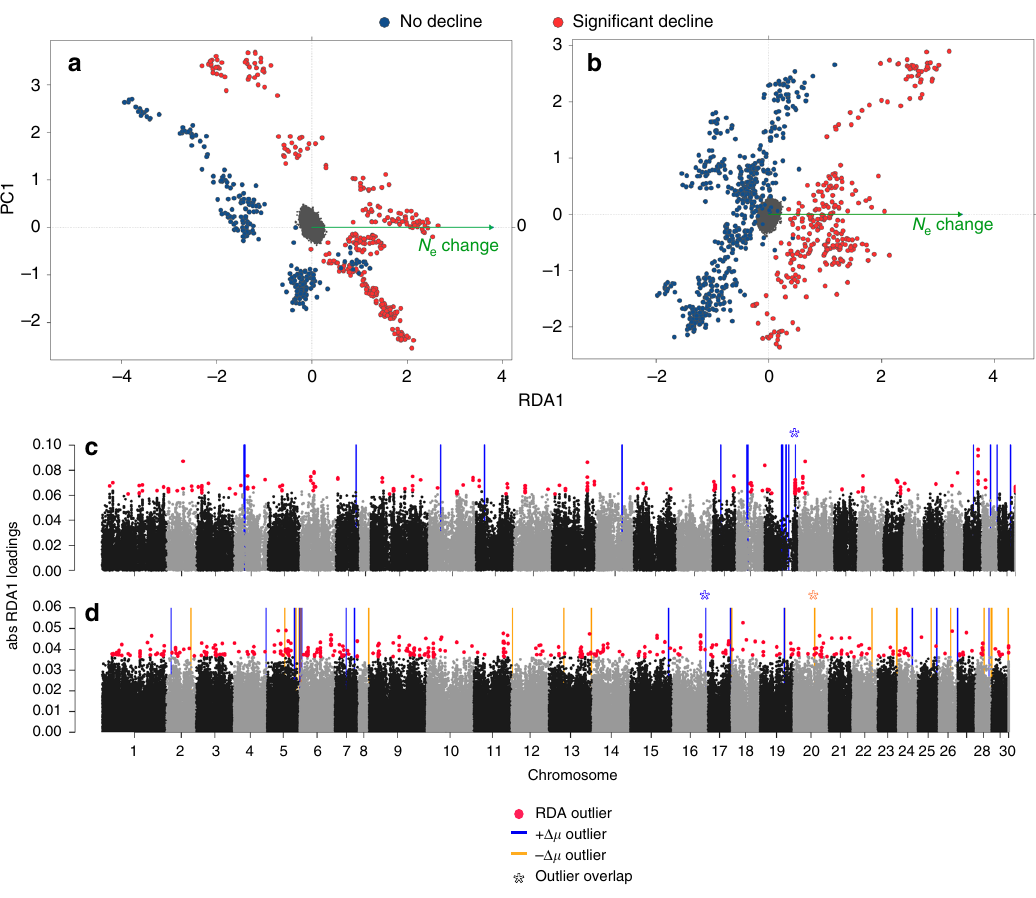
Fig. 3 Genomic basis of population declines across Atlantic salmon using high-density genomic dataset. Redundancy analysis (RDA) separated signi fi cantly declining (red) and non-declining (blue) populations along the fi rst axis in ( a ) North America and ( b ) Europe. Absolute RDA1 scores are presented in Manhattan plots for both continents ( c , North America; d , Europe) with decline-associated loci (outliers) highlighted in red. Coloured lines represent regions showing signi fi cant changes in selective sweeps ( Δ µ ) between declining and non-declining populations, where blue lines ( + Δ µ outlier) suggest an absence of selective sweeps in declining populations and orange lines ( − Δ µ outlier) suggest the presence of selective sweeps associated with declines. Asterisks (*) indicate regions with overlap between Δ µ and decline-associated SNPs (RDA) within each continent. SNPs on chromosome 30 represent those that did not align to known positions in the